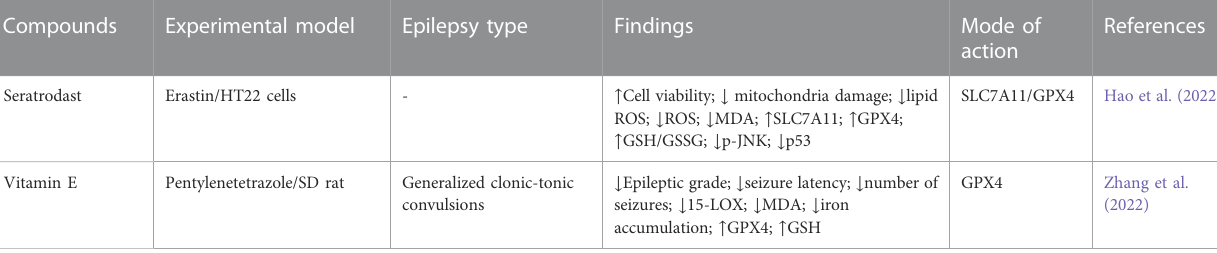
A1 astrocytes and neuronal ferroptosis in patients with epilepsy.